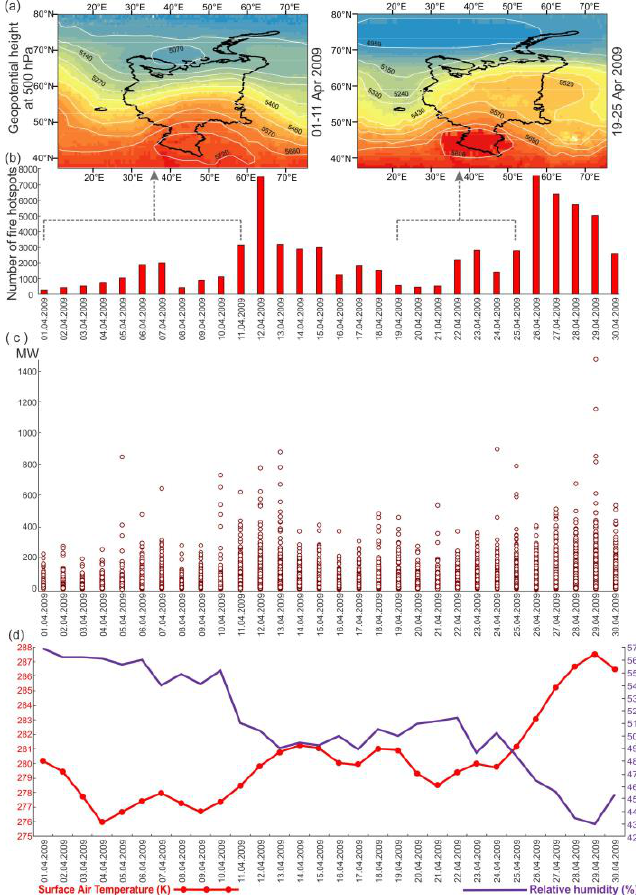
Figure 4. Changes in meteorological conditions and fire activity in the European part of Russia in April 2009: maps of geopotential height changes ( a ); distribution of the daily number of wildfire hotspots ( b ); distribution of daily FRP values ( c ); changes in the surface air temperature and relative humidity ( d ).